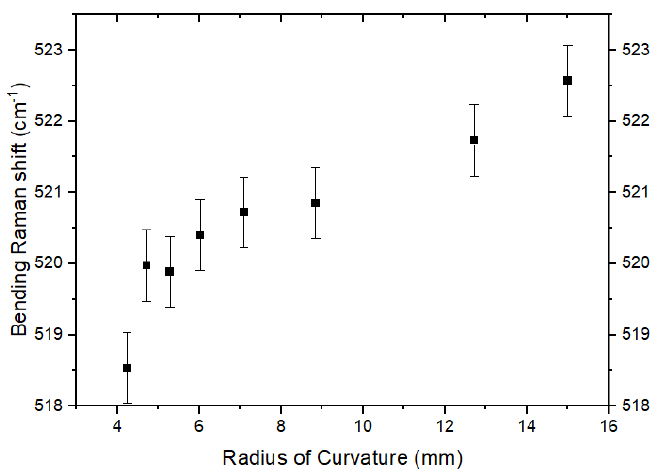
Figure 7. Bending Raman shift as a function of radius for tensile (positive) bending for a p-type sample. The Raman shift moves to lower values with decreasing radius suggesting the creation of a local tensile strain in the crystalline